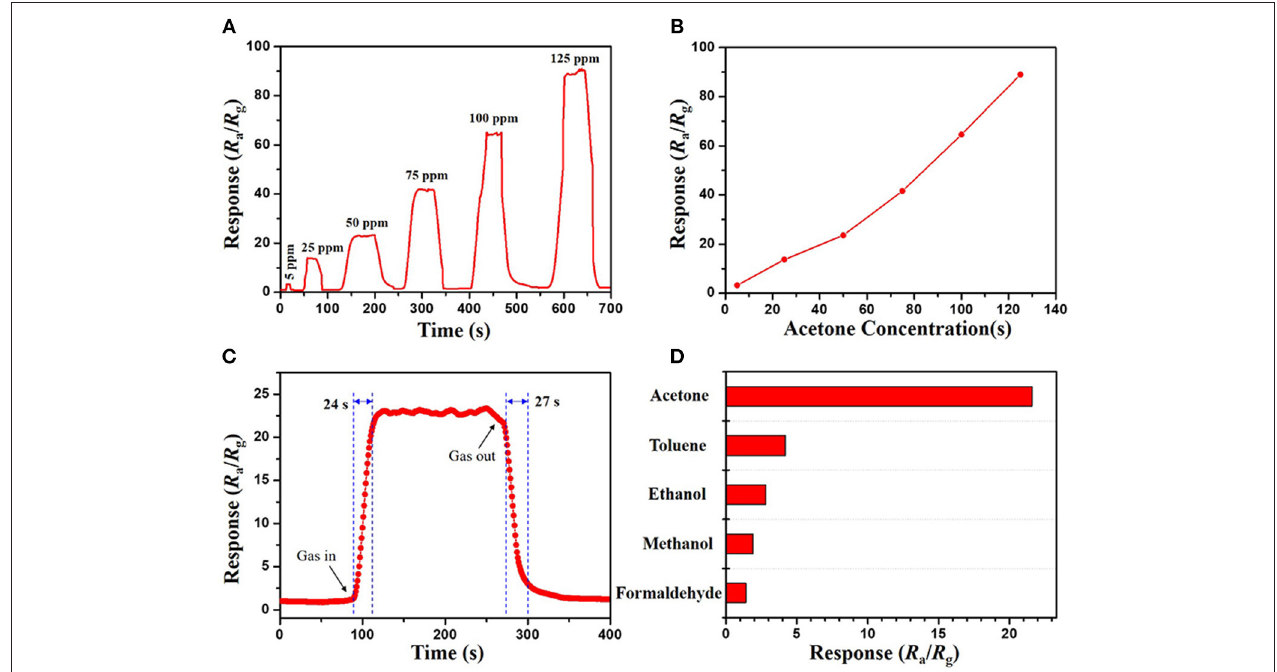
FIGURE 5 | (A) response–recovery curve and (B) relationships between acetone concentration and response of the mesoporous WO 3 -25 NFs sensor to acetone vapors of different concentrations. (C) dynamic response–recovery curve of mesoporous WO 3 -25 NFs sensor to 50 ppm acetone. (D) responses of the mesoporous WO 3 -25 NFs sensor to various gases at 50